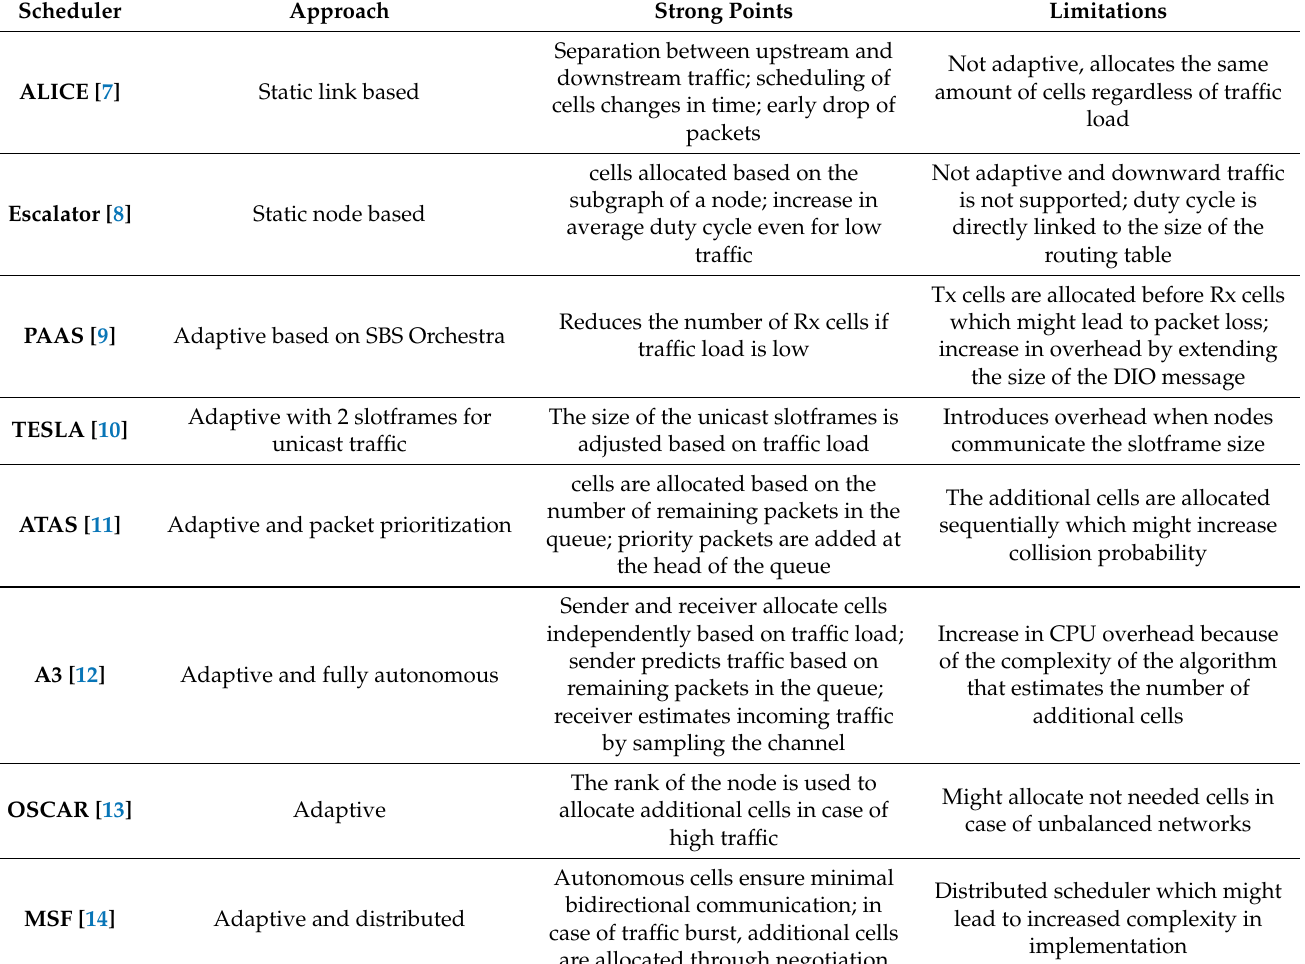
Table 1. Strong points and limitations of discussed